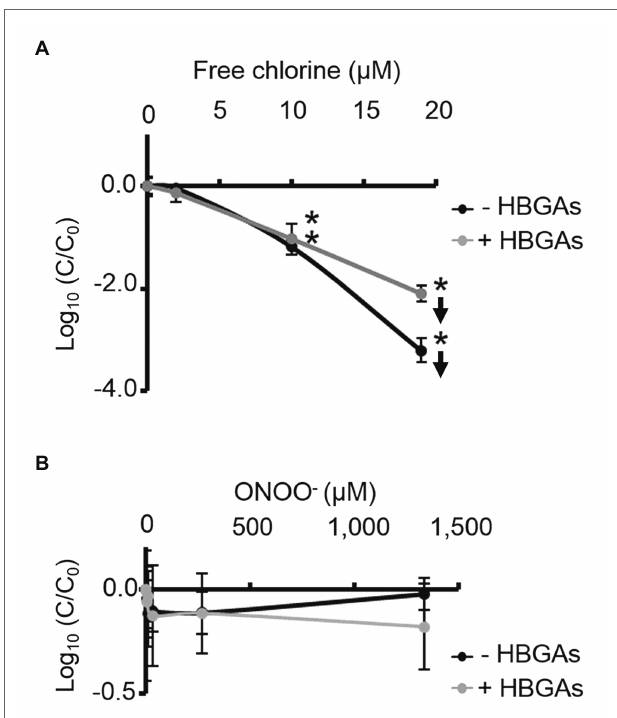
FIGURE 5 | Free chlorine and ONOO − decrease HBGA-binding to complete GII.4 HuNoVs. Assays of HBGA-binding to encapsidated GII.4 HuNoVs in ALe + saliva following free chlorine (A) and ONOO − (B) treatments were presented. Complete HuNoVs correspond to viral particles treated with RNase at a final concentration of 100 μ g.ml −1 for 1 h at 37 ° C. The black line and gray line represent complete HuNoVs quantified by RT-qPCR and complete HuNoVs after HBGA-binding followed by RNA amplification using RT-qPCR, respectively. The log (C/C 0 ) values were calculated by dividing the mean GII.4 HuNoV gc values following oxidative treatment (C) by the mean GII.4 HuNoV gc values in the untreated control (C 0 ). Each data point corresponds to the mean data value of duplicates of three independent experiments carried out on different days. Error bars indicate standard deviations. Arrows ( ↓ ) indicate data below the quantification limit. *Unpaired Student’s t -test and Mann-Whitney U tests were used to compare groups with p <